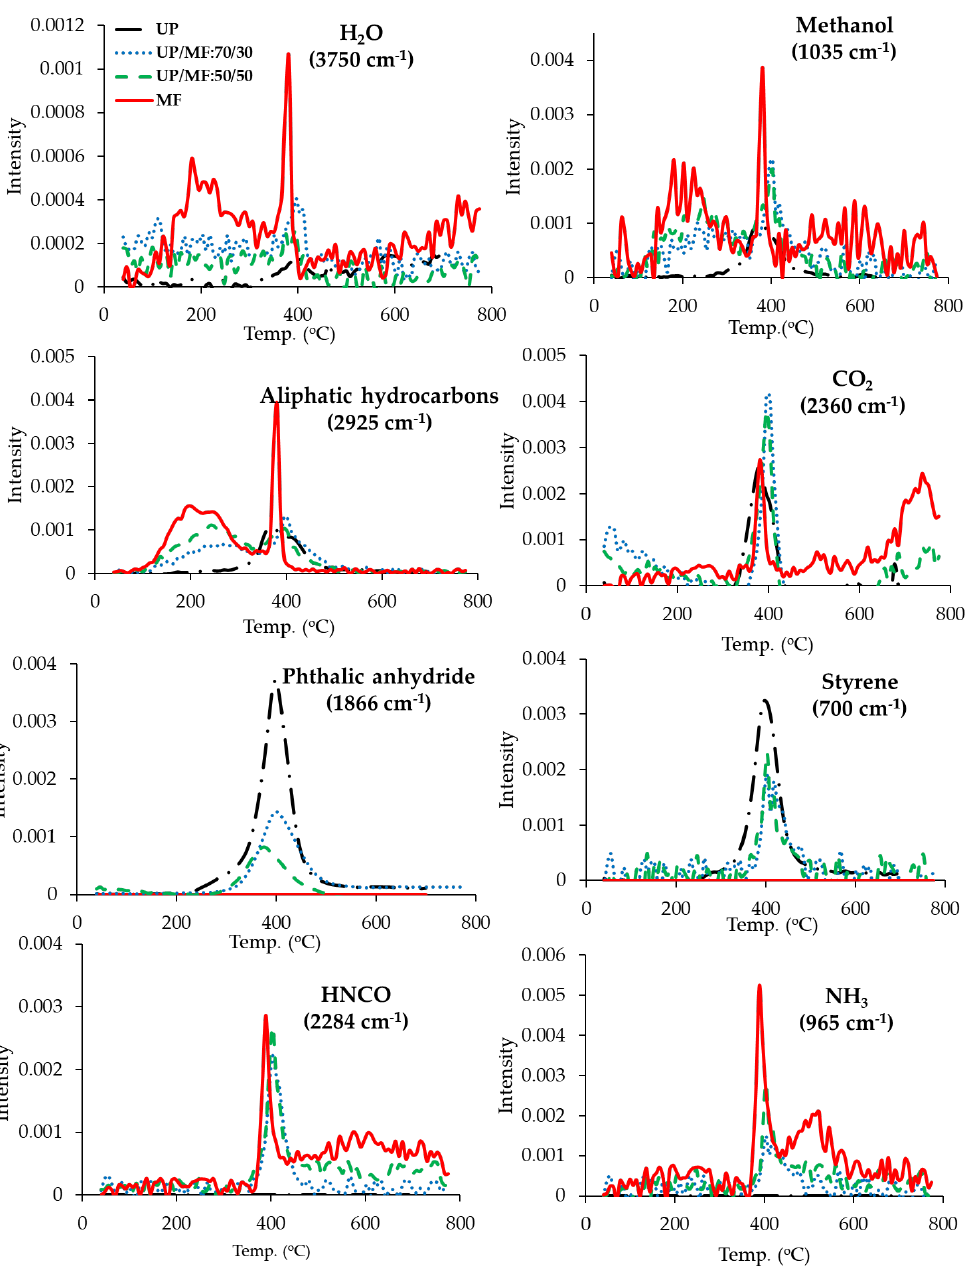
Figure 6. Absorbances of pyrolysis products for UP, MF, and UP/MF blends as a function of temperature obtained from TGA-FTIR in nitrogen.